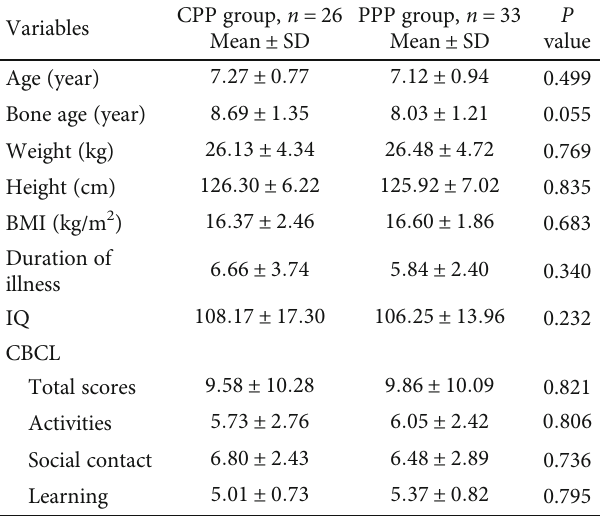
Table 1: Clinical characteristics of participants.